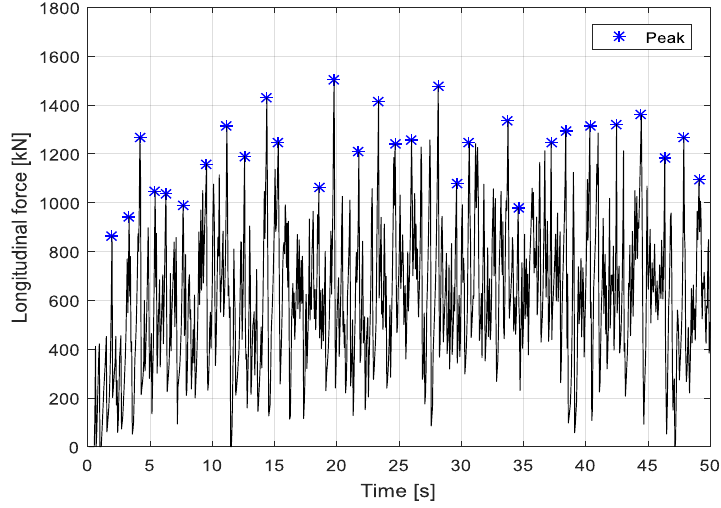
Figure 11. Numerical and measured ice force as a factor of ice speed.